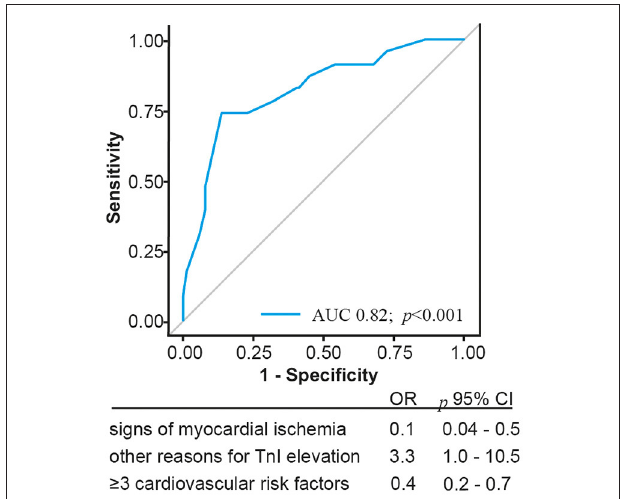
FIGURE 2 | Illustration of the Receiver operating characteristics curve and corresponding Areas of predictors indicating absence of coronary artery disease; CI, confidence